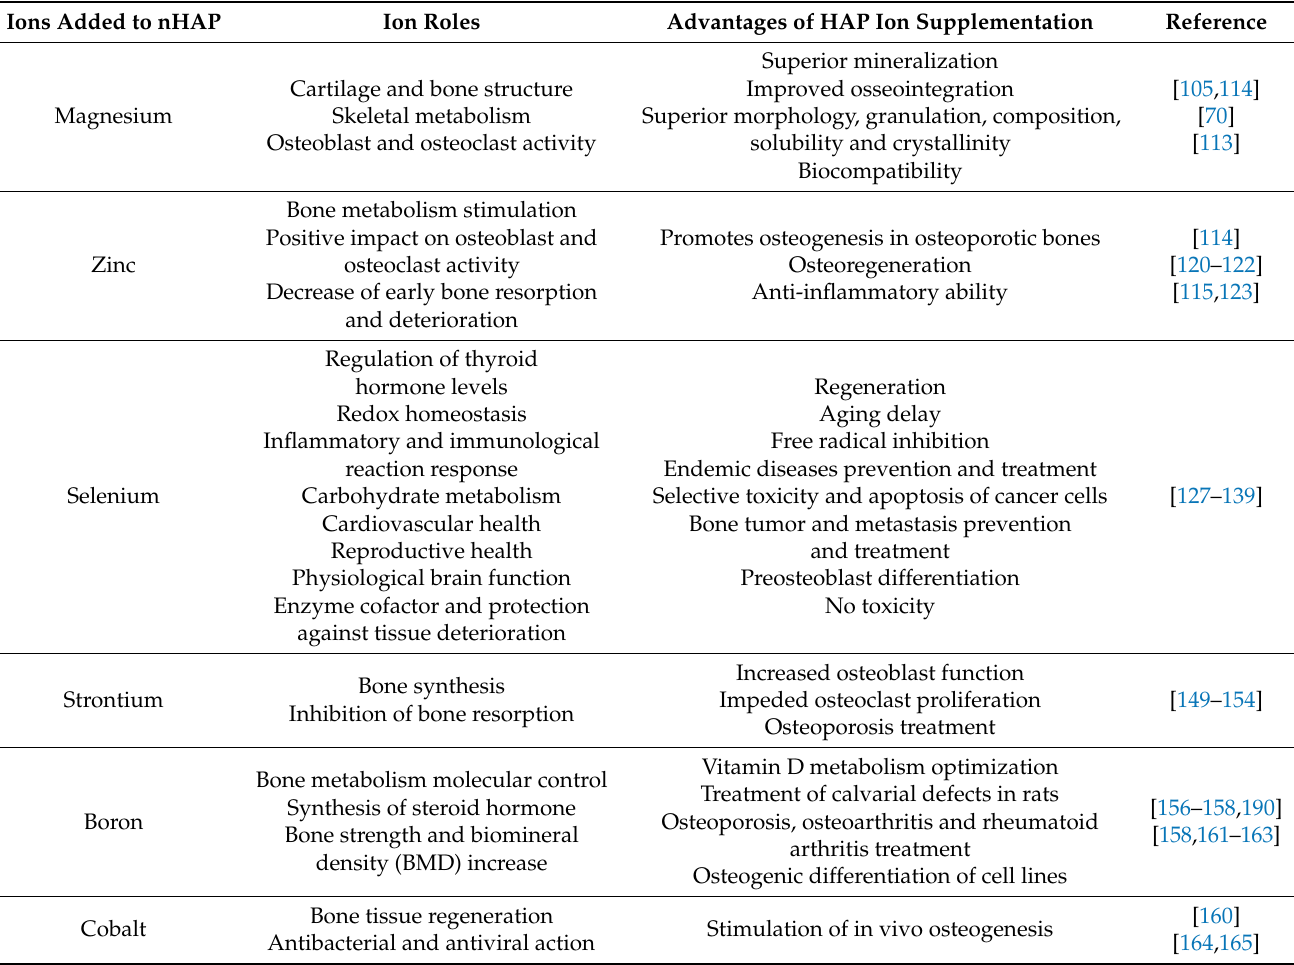
Table 3. Hydroxyapatite combined with ions: roles of ions and supplementation